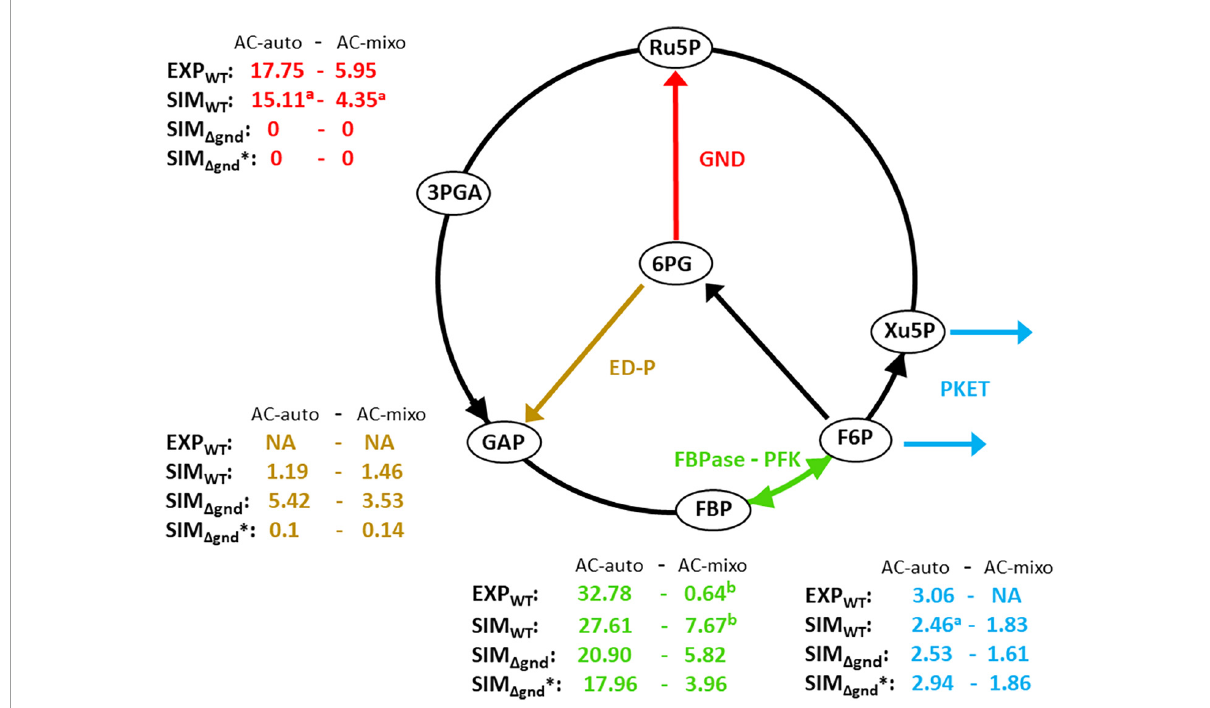
FIGURE2 Experimental and simulated flux distribution via glycolytic pathways under autotrophic and mixotrophic conditions. Brown color shows the flux via Entner–Doudoroff pathway, blue color shows the flux via phosphoketolase (PKET) pathway, green color indicates the net flux via futile cycle of fructose-1,6 bisphosphatase (FBPas) and phosphofructokinase (PFK), red color shows the flux via 6-phosphogluconate dehydrogenase (GND). Index “ a ” denotes the cases of possible match between experiments and simulations if flux via ED-P is not considered in model; flux via ED-P was not considered in experimental-based calculations (Nakajima et al., 2014; Hing et al., 2019). Index “ b ” shows the case of simulated result being in the confidence interval of experimental value. All data were taken or simulated under ambient CO 2 condition. (i) lower flux FBPase – PFK (green) under mixotrophic conditions is caused by redistribution of carbon flow, i.e., higher flux via EMP-P in expense of Calvin-Benson cycle (ii) flux values presented in this figure and Table 4 vary to some degree because they represent two independent and alternative calculations (two best fits). Units of metabolic fluxes: 10 - 2 mmol h - 1 gDW - 1